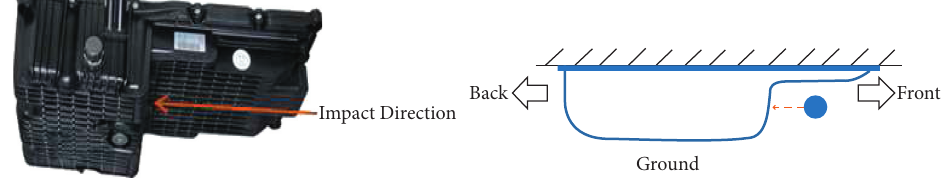
Figure 3: Ball impact position and direction.